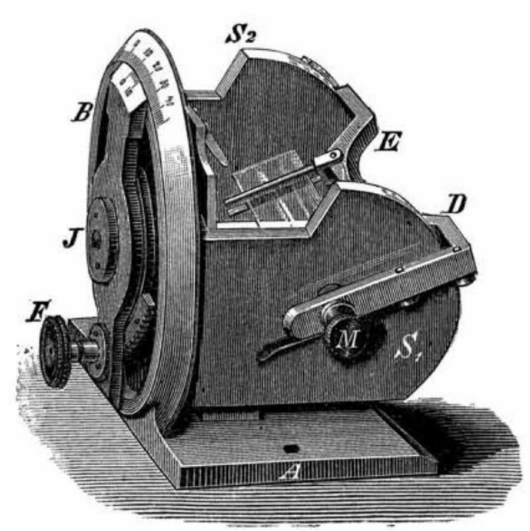
Figure 8. Microscope Universal Stage (U-Stage or Fedorov stage) with independently tilting ( J ) and rotating ( M ) axes. The specimen is placed on a glass plate (two points of the sample holder D and E are indicated, which may be rotated around axis M). The two axes enable to orient crystallographic and optical planes of the crystal to the reference system of the microscope. The device allowed quick measurements of optical properties using thin sections of minerals. Later on, it has been refined with five axes of rotation for the study in any cross section. (E. v. Fedorov, [53], p. 235, Figure 2).